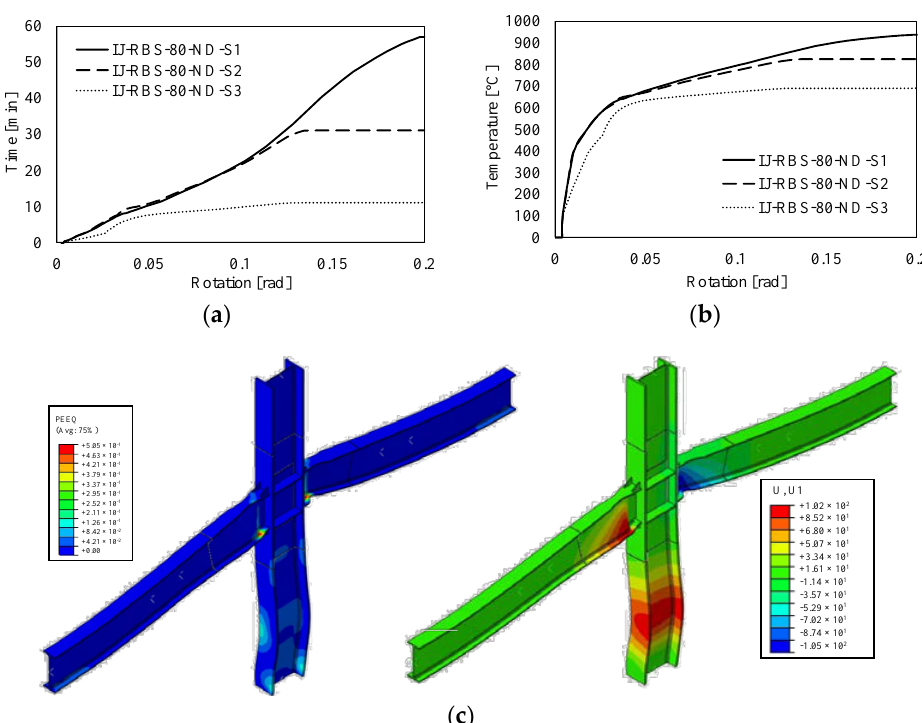
Figure 10. Results of the IJ-RBS-80 joints in terms of time–rotation curve ( a ), temperature–rotation curve ( b ) and PEEQ ( c ).